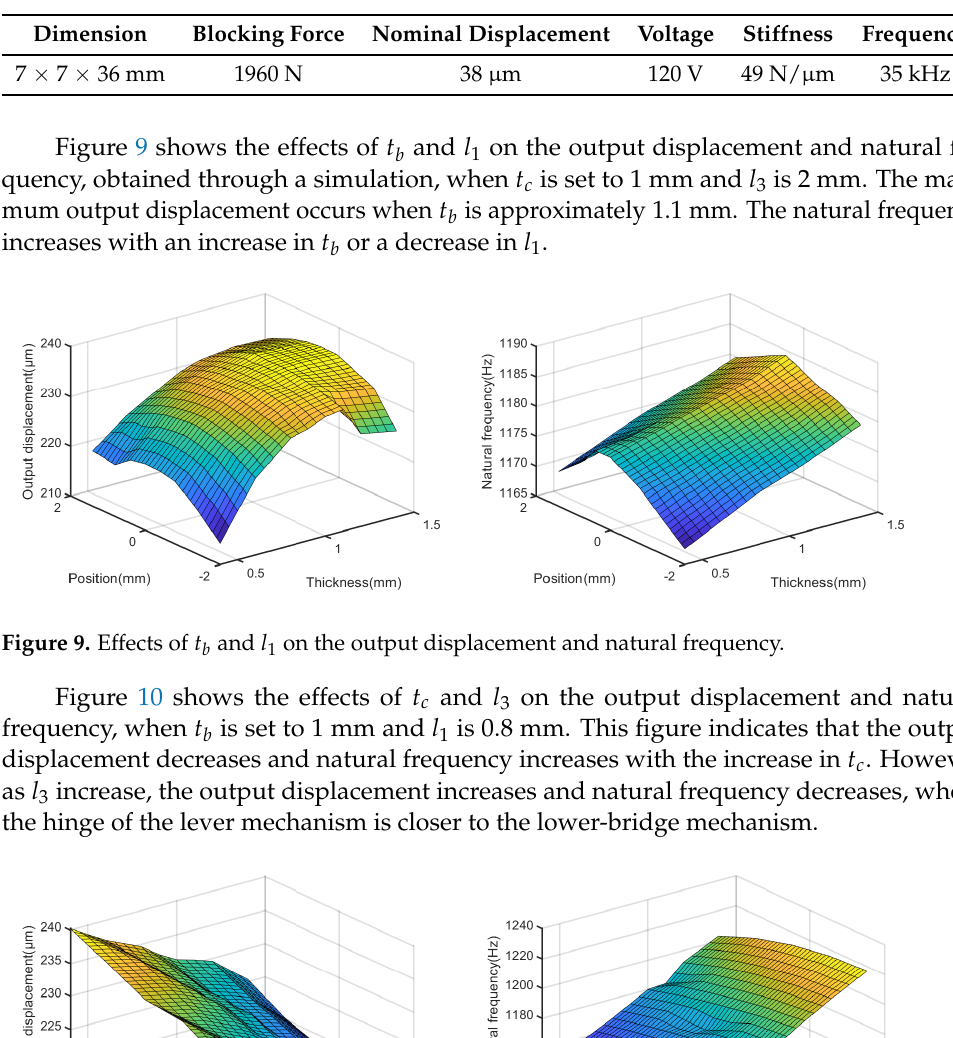
Table 3. The technical parameters of adopted piezo-stack.